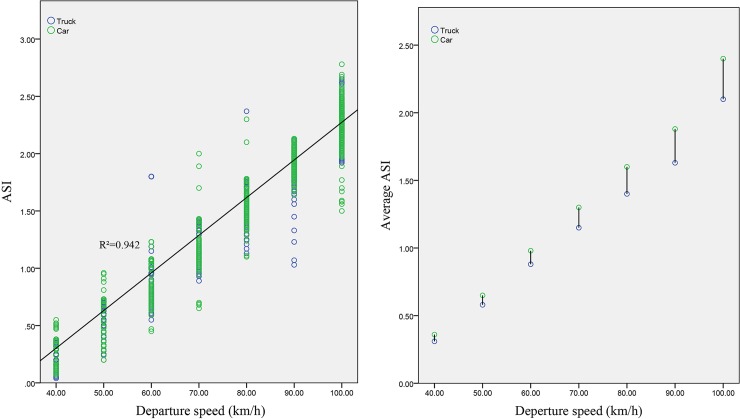
Relationship between the ASI and the departure speed.